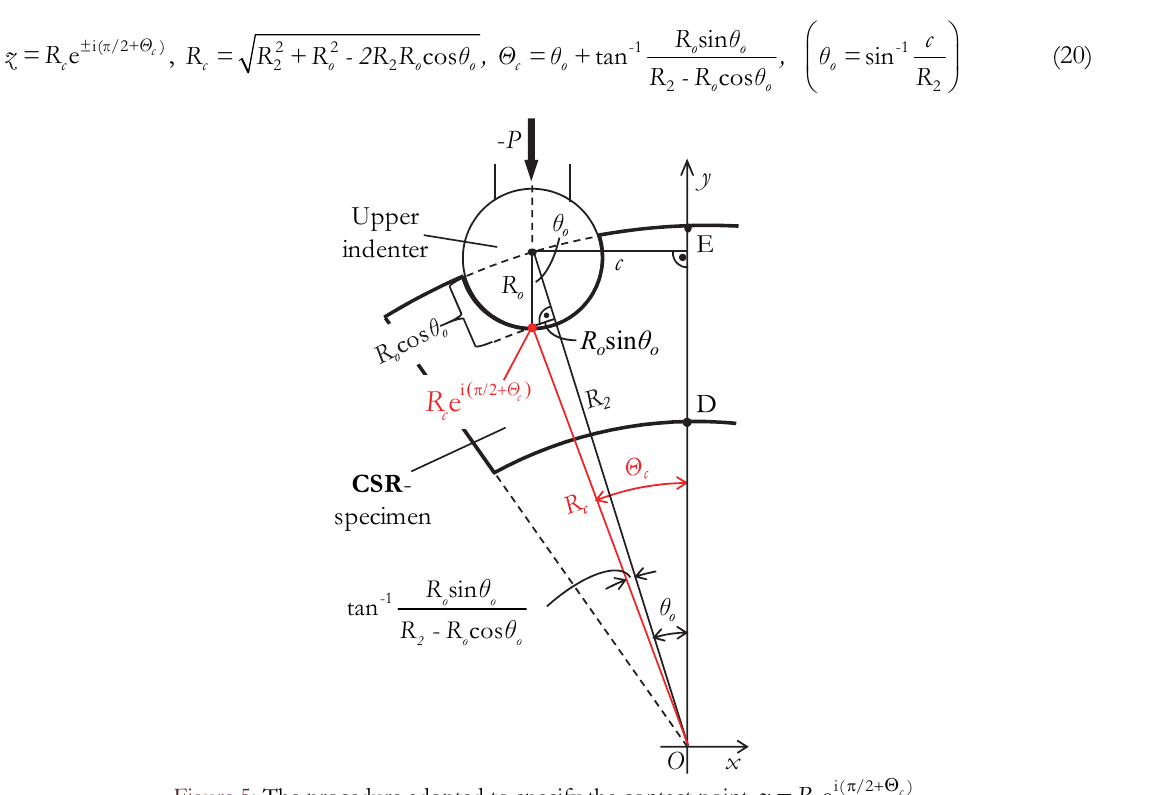
Figure 5: The procedure adopted to specify the contact